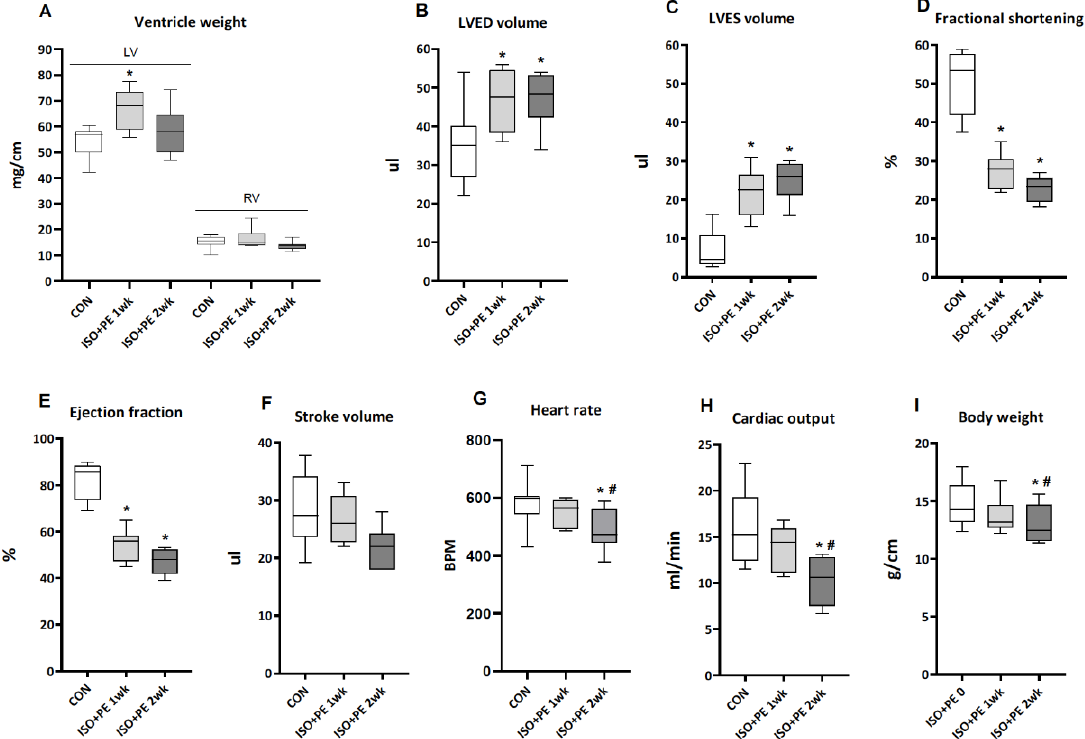
Figure 3. The effect of one and two weeks of ISO + PE infusion on cardiac parameters and body weight. ( A ) Ventricle weight was normalized to tibia length. Data in panels ( B – H ) were obtained by echocardiography. ( B ) LVED: left ventricular end-diastolic; ( C ) LVES: left ventricular end-systolic. Data are presented as median and quartiles with whiskers indicating minimum and maximum val-